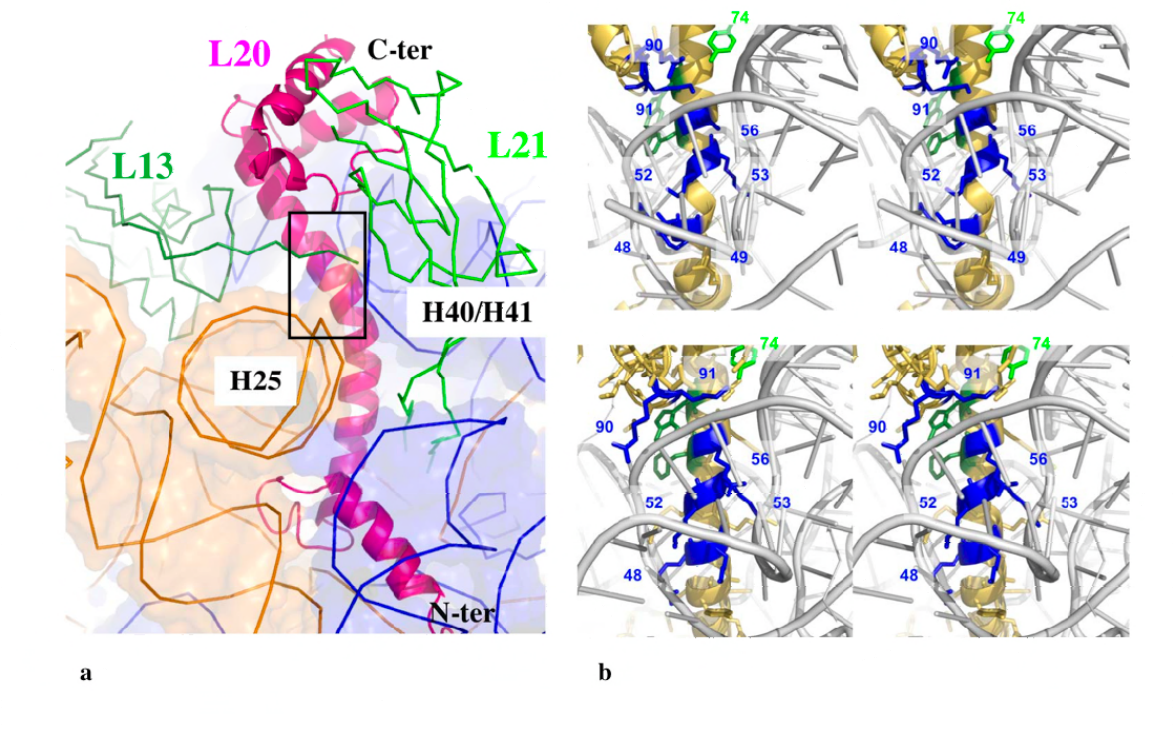
Figure 4. (a) The path of L20 within the core of the large subunit of T. thermophilus [14] (as a representative structure for eubacteria). The box represents the region that is zoomed in b. (b) The interaction of the basic residues (blue) of cluster of the helix α 2 of L20 with the 23 S RNA within the 50 S subunit of E. coli (up) [15] and of T. thermophilus (bottom) [14]. The numbering of residues is shifted to fit to the sequence of A. aeolicus (-2